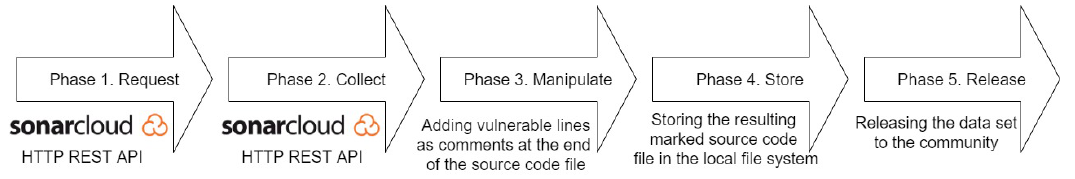
Figure 3. SonarCloud detecting use of an insecure